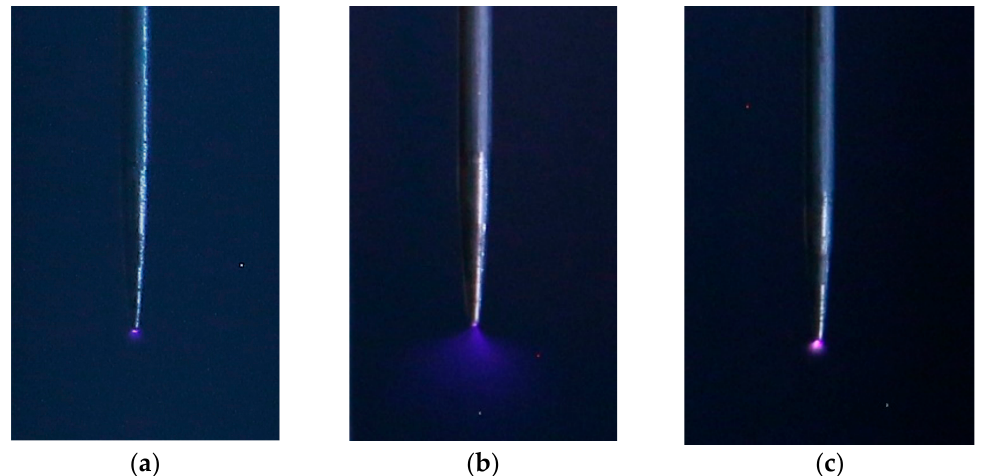
Figure 6. Needle-plane gap. Photographs were taken with the DSLR camera. ( a ) Alternating current corona at 1 m. ( b ) Positive dc corona at 1 m. ( c ) Negative dc corona at 1 m.